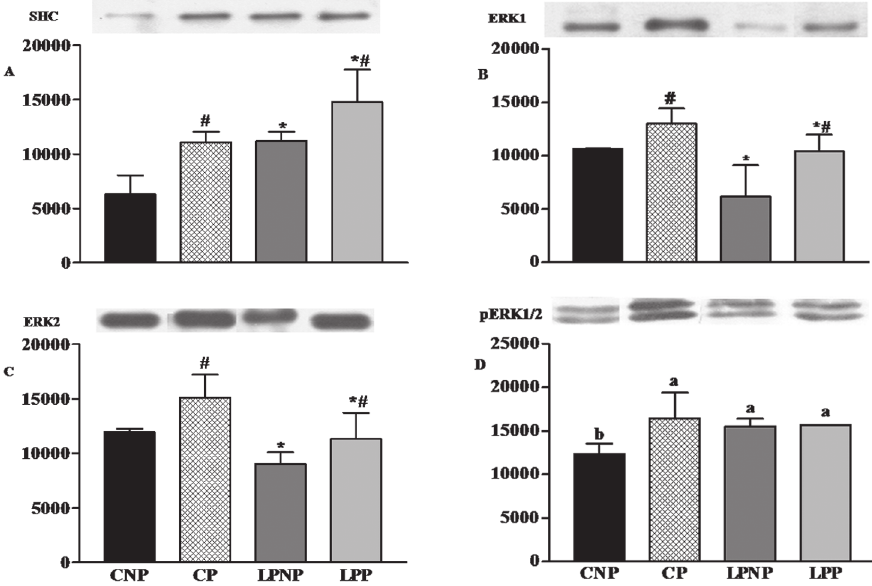
Figure 2 - The levels of the SHC (A), ERK1 (B) and ERK2 proteins (C) and phospho-ERK1/2 levels (D) in the islets of CNP, CP, LPNP and LPP rats. Equal amounts of protein (50 µg) were run on SDS-PAGE and blotted with anti- SHC, anti- ERK1, anti-ERK2 and anti-phospho-ERK1/2. The columns represent the means ± SDs of 3-4 independent experiments. # Indicates differences in relation to non-pregnant rats (Two-way ANOVA, P <0.05). *Indicates differences in relation to rats maintained on a control diet (Two-way ANOVA, P <0.05). a,b Mean values with unlike superscript letters were significantly different (LSD test; P